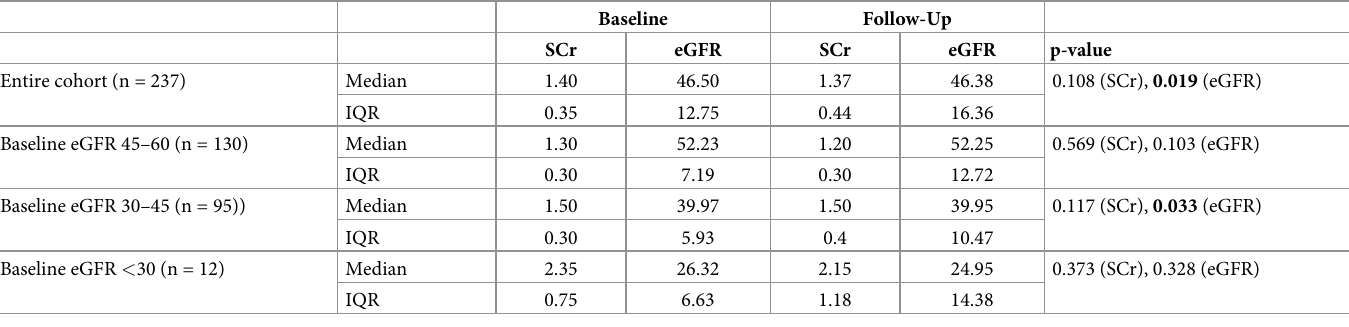
Table 2. Serum creatinine and eGFR at baseline and follow-up for entire cohort and baseline eGFR subgroups.